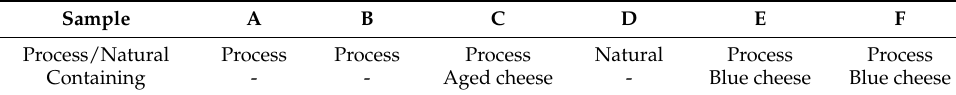
Table 1. Feature of 6 cheese